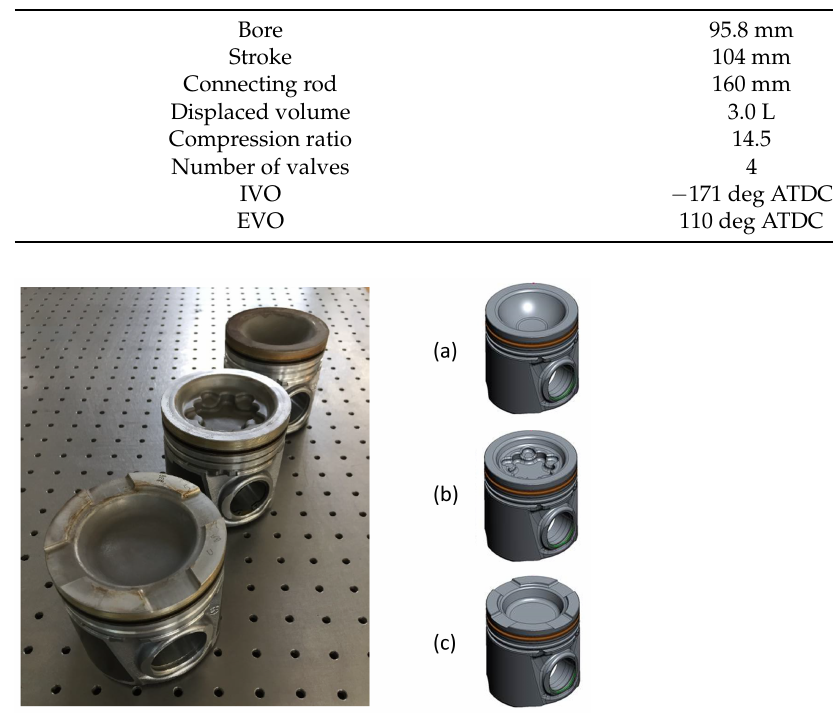
Table 2. Main engine geometry data of the simulated SI engine.